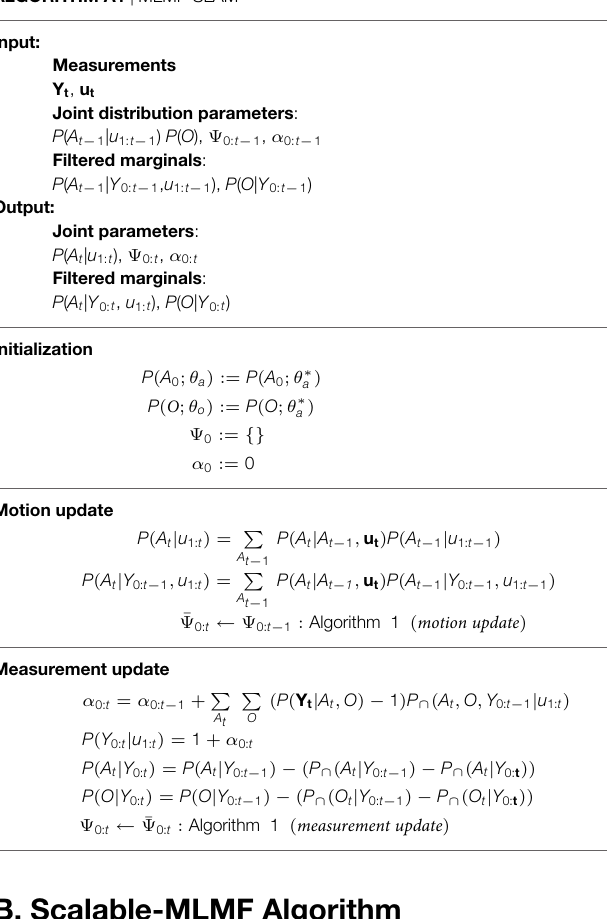
ALGORITHM A1 | MLMF-SLAM